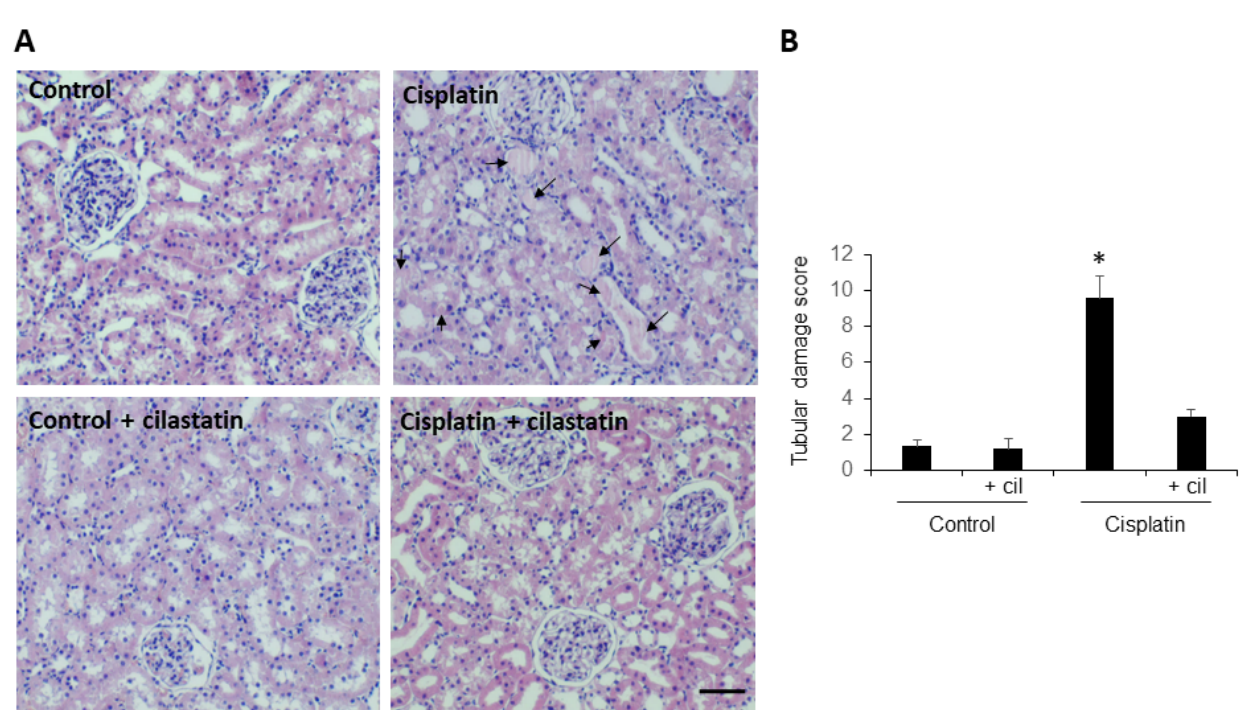
Figure 1. Cilastatin reduces histopathological damage induced by cisplatin administration. ( A ) Representative images of the hematoxilyn-eosin-stained renal cortex and medulla of control, cilastatin, cisplatin and cisplatin + cilastatin rats (20× magnification). Arrows point to intratubular protein casts from animals treated with cisplatin. The rest of the groups presented an apparently normal renal morphology. Bar = 100 µm. ( B ) Semiquantitative tubular damage score. Results are expressed as mean ± s.e.m., n = 6 animals per group. * p < 0.005 vs. all other groups.